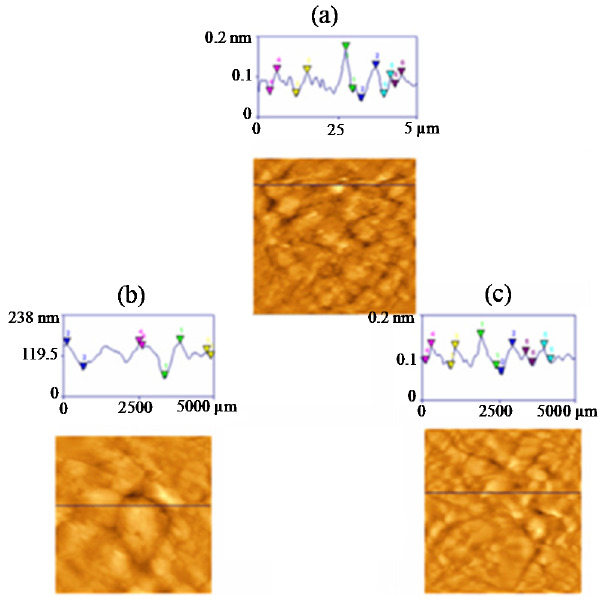
Figure 8. AFM line profile of the top surface of styrene ‐ acrylonitrile ‐ blended PVDF membranes. ( a ) 100% PVDF; ( b ) 60% styrene ‐ acrylonitrile blend; ( c ) 100% styrene ‐ acrylonitrile membranes.